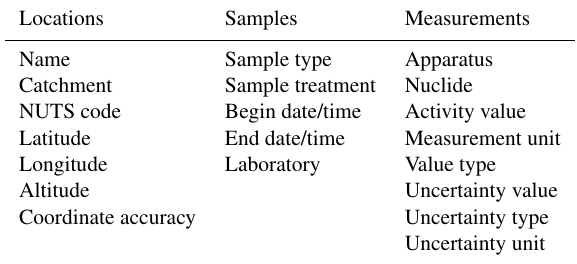
Table 1. Minimum requirements associated with data stored in